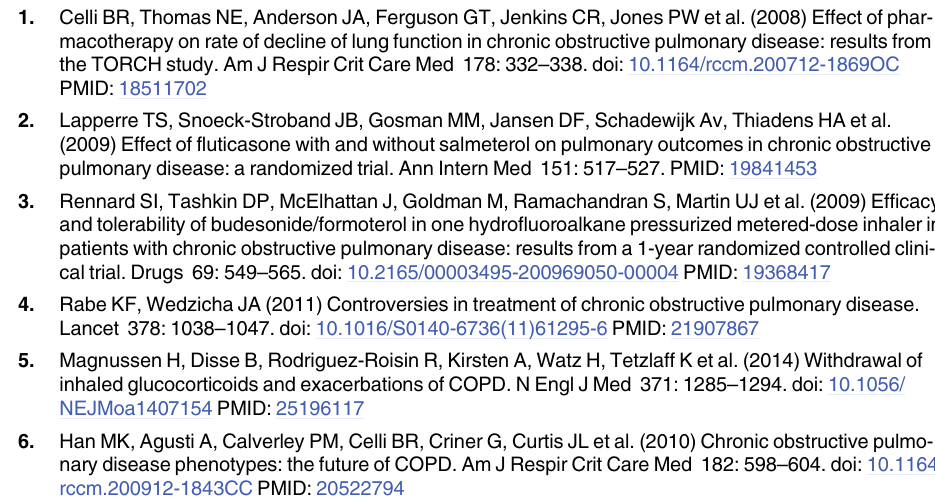
S1 Table. Dataset. http://figshare.com/s/c279dbb0639711e5aece06ec4b8d1f61